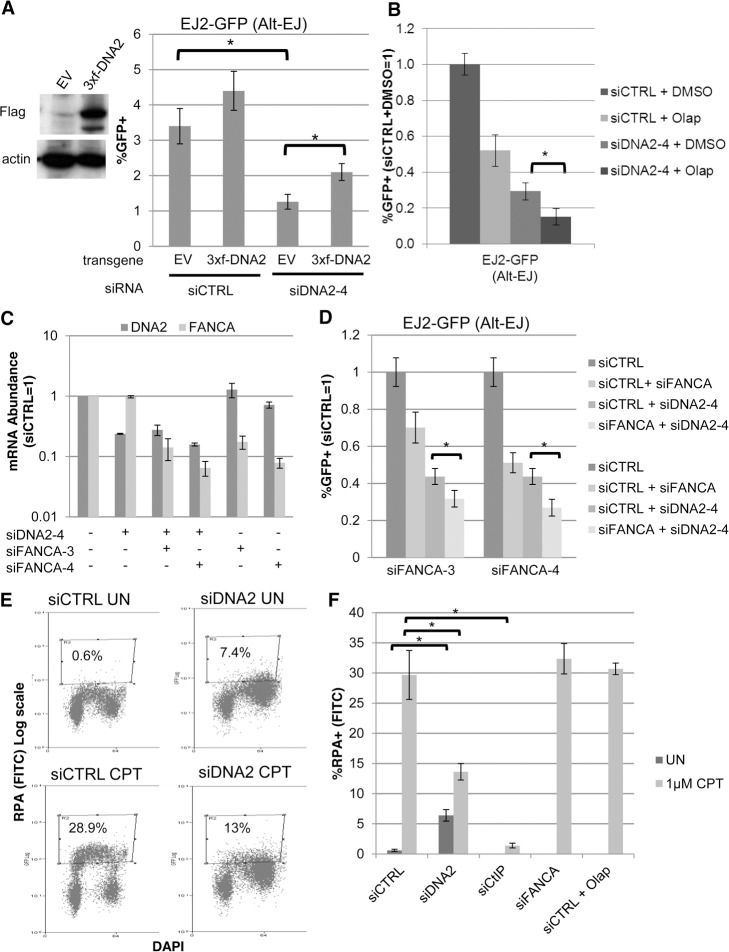
DNA2 has distinct effects on Alt-EJ and end resection, compared to FANCA and PARP.(A) Stable expression of DNA2 increases Alt-EJ in cells treated with an individual siRNA targeting endogenous DNA2 (siDNA2–4). U2OS EJ2-GFP cells were transduced with an expression cassette for DNA2 with a 3xFlag immunotag and silent mutations for resistance to siDNA2–4, or transduced with EV. These cell lines were treated with siDNA2–4 or siCTRL, and transfected with expression vectors for I-SceI, or a GFP expression vector in parallel to quantify percent transfected cells. Shown are the %GFP+ frequencies from the I-SceI transfections, normalized to transfected cells. *P<0.0001 (n = 9). (B) PARPi treatment and DNA2 depletion cause an approximately additive decrease in Alt-EJ. U2OS EJ2-GFP cells were treated with siCTRL or siDNA2–4 prior to expression of I-SceI and treatment with 5 μM Olaparib (Olap) or vehicle (DMSO). Shown are %GFP+ frequencies relative to siCTRL/DMSO treated cells. *P<0.0001 (n≥6). (C) The relative mRNA abundance of FANCA and DNA2 is shown for U2OS cells treated with siCTRL, siDNA2–4, siFANCA-3, and/or siFANCA-4 (qRT-PCR analysis as in Fig. 1D, fold reduction based on 2ΔΔCt). (D) RNAi targeting of DNA2 and FANCA cause an approximately additive decrease in Alt-EJ. Shown are the GFP+ frequencies of EJ2-GFP U2OS cells treated with siDNA2–4 alone or in combination with siFANCA-3 or siFANCA-4, prior to examining Alt-EJ as in B, each normalized to siCTRL. *P<0.0001 (n≥6). (E) End resection assay. Cells were detergent extracted prior to fixation and staining with RPA and DAPI, which was analyzed for individual cells by flow cytometry. Shown are representative plots for siRNA-treated (siCTRL or siDNA2 pool) U2OS cells incubated with camptothecin (CPT) or mock treated (UN). (F) RNAi targeting of DNA2 and CtIP, but not FANCA, nor treatment with Olaparib, causes a decrease in end resection. Cells were treated with siRNA and Olaparib prior to treatment with CPT for the end resection assay. Shown is the percentage of U2OS cells with chromatin-bound (i.e. detergent-resistant) RPA staining for the given siRNA and drug treatments, as quantified using the assay shown in E. *P<0.0002 (n≥3).